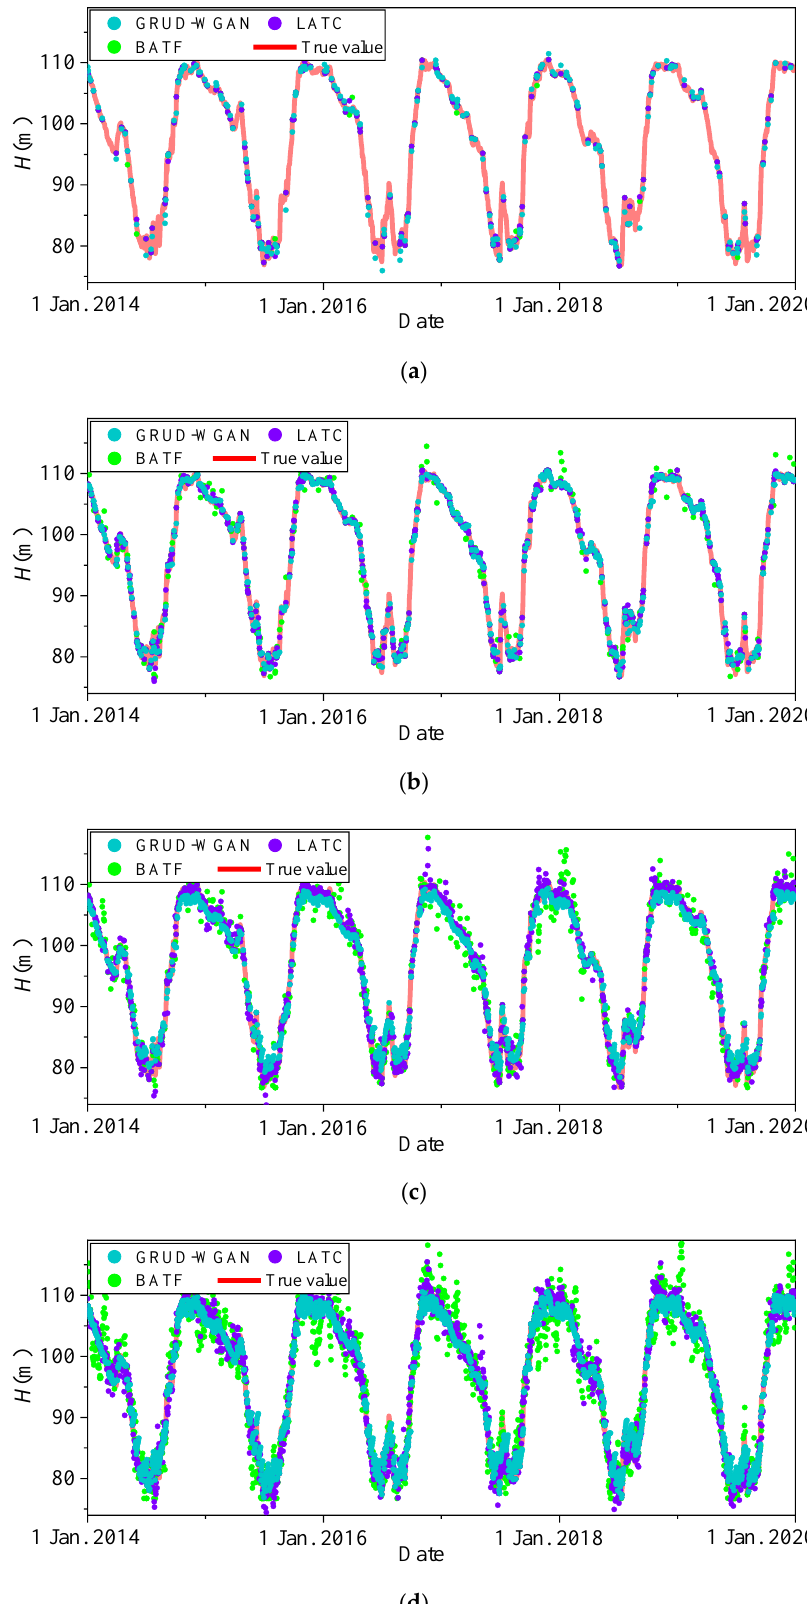
Figure 18. The result of data imputation with various missing rates: ( a ) r = 0.1; ( b ) r = 0.3; ( c ) r = 0.5; and ( d ) r =